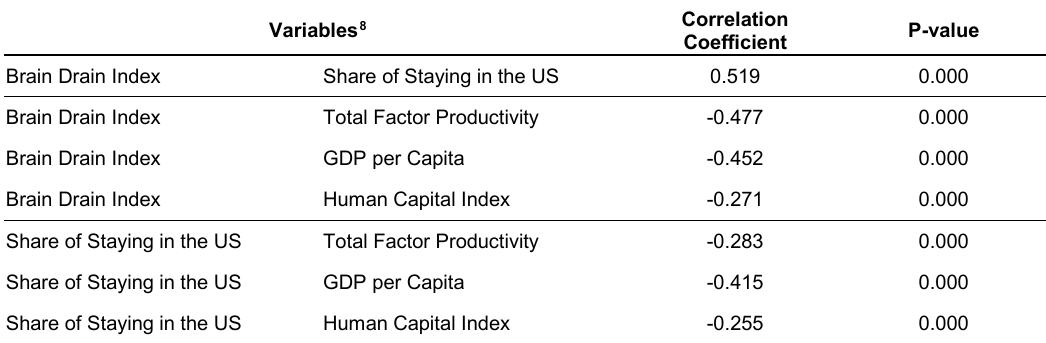
Table 4 . Pearson correlation analysis between brain drain index and selected macroeconomic